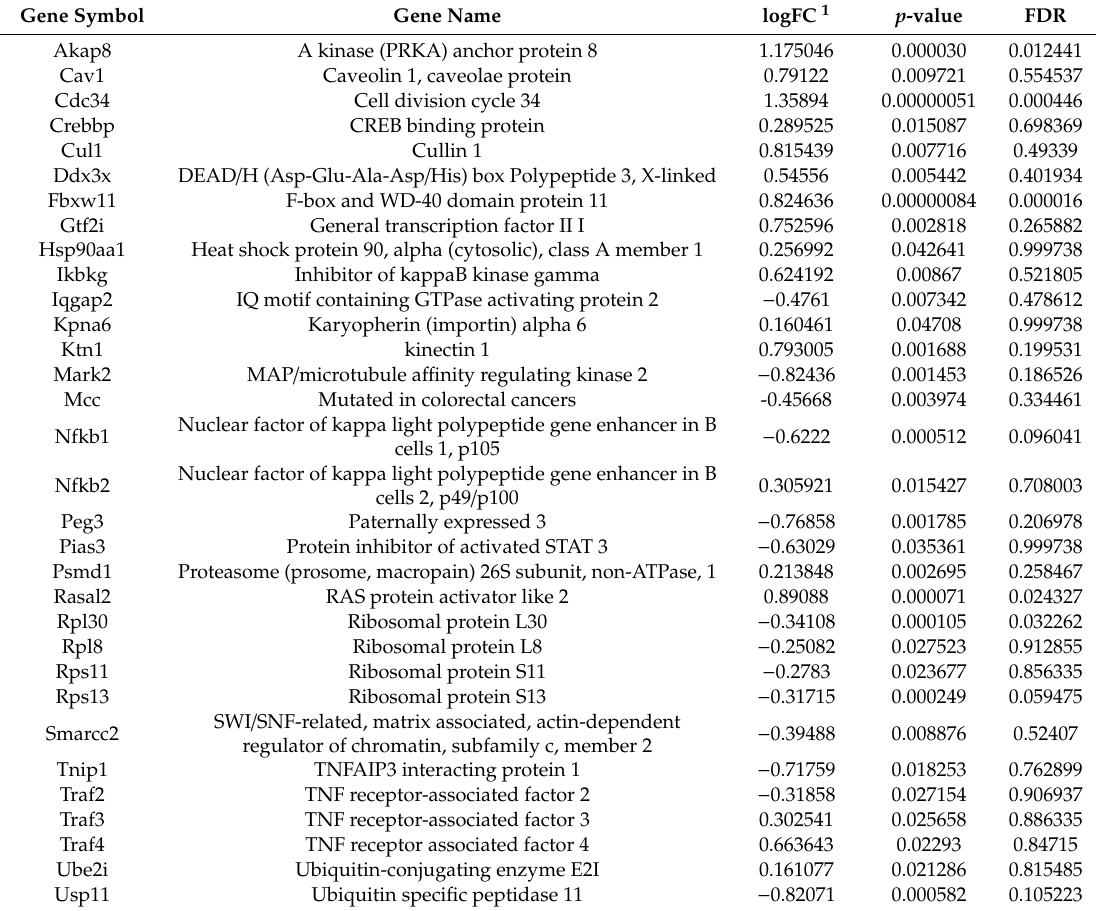
Table 2. List of TNF-alpha NF-kB Signaling Pathway genes with logFC, p -value, and FDR values. Gene